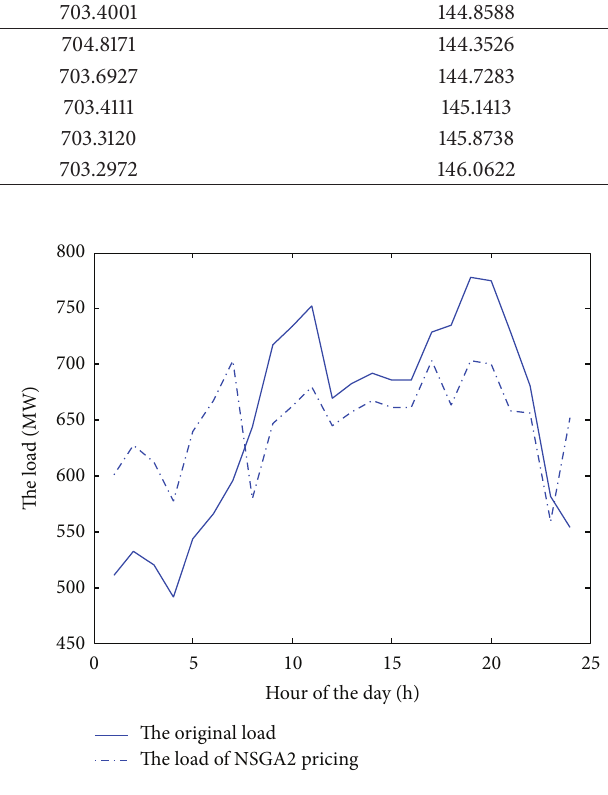
Figure 5: Contrast of load curve between optimization by NSGA2 and the original